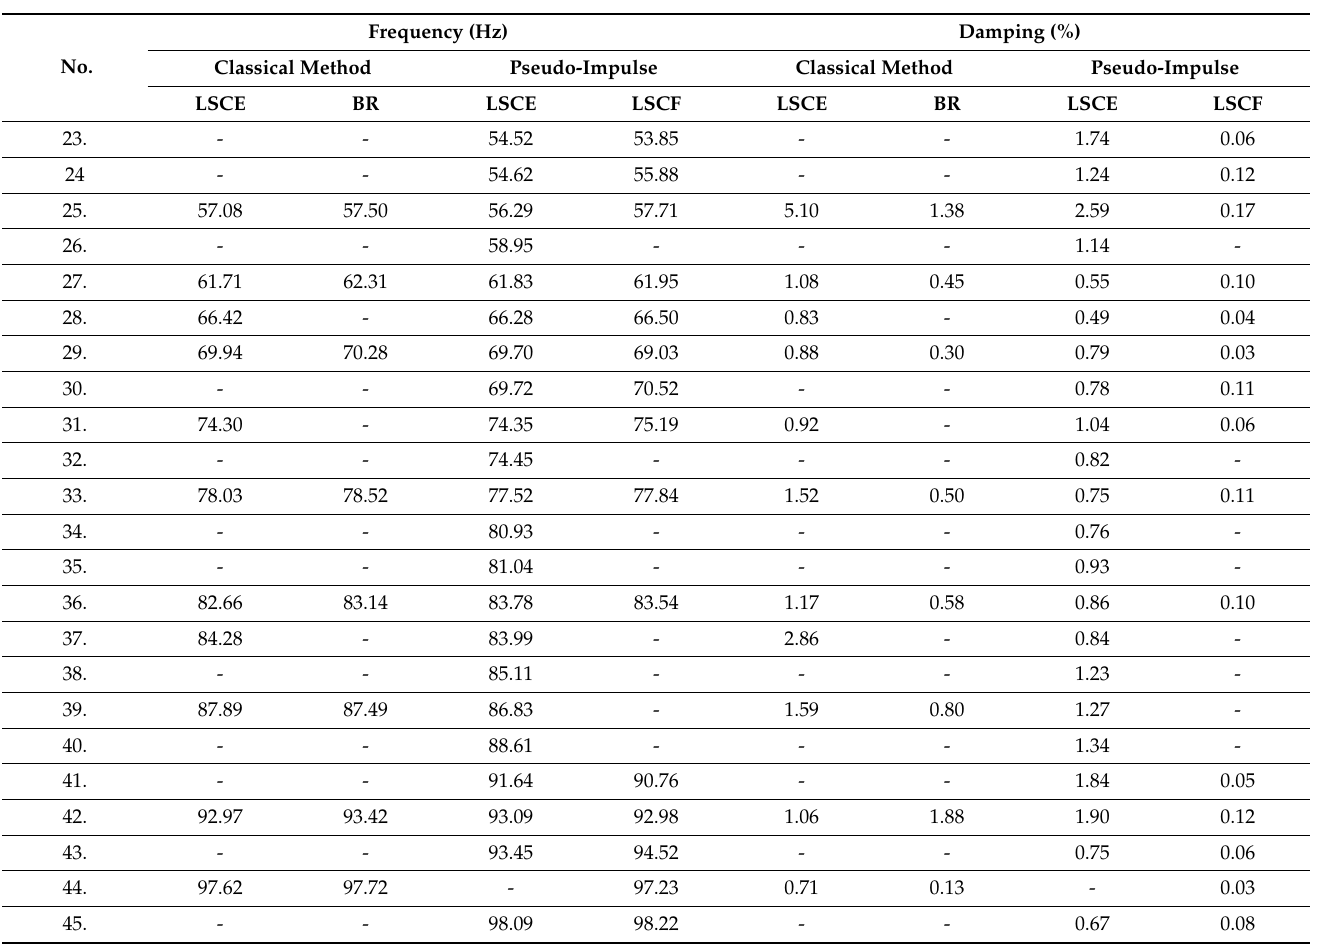
Table 2. Comparison of modal parameters estimated with the application of classical and pseudo- impulse methods (modes